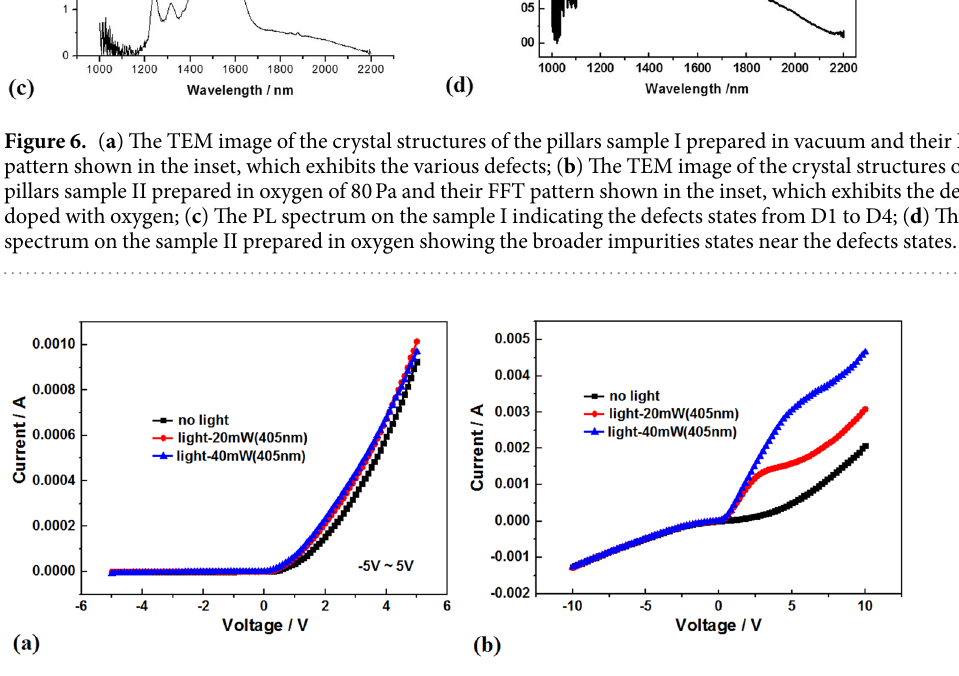
Figure 7. ( a ) The I-V curves in dark (black curve) and in light field (red and blue curve) of laser at 405 nm on the pillars sample I prepared in vacuum; ( b ) The I-V curves in dark (black curve) and in light field (red and blue curve) of laser at 405 nm on the pillars sample II prepared in oxygen, in which the quantum effect of photo- generated carriers obviously